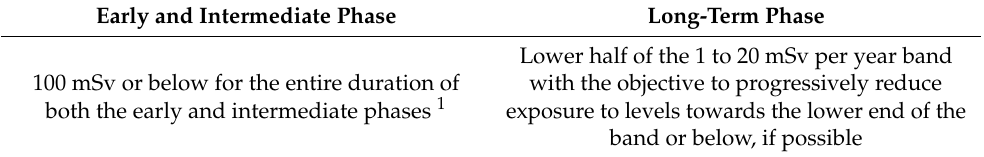
Table 1. Updated reference levels for guiding the optimization of protection of members of the public during the successive phases of a nuclear accident